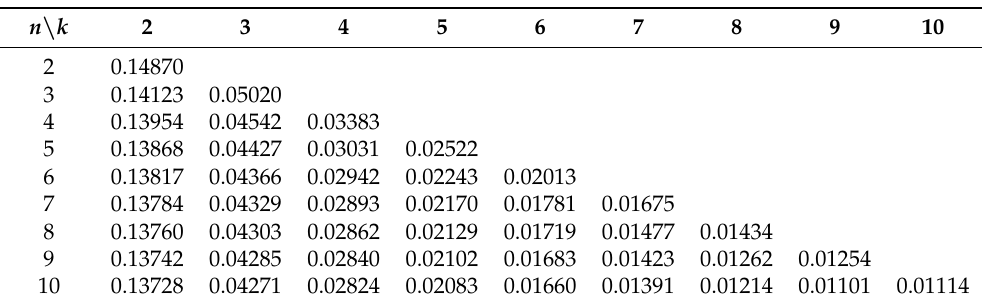
Table 2. Coefficients Γ k n for H =